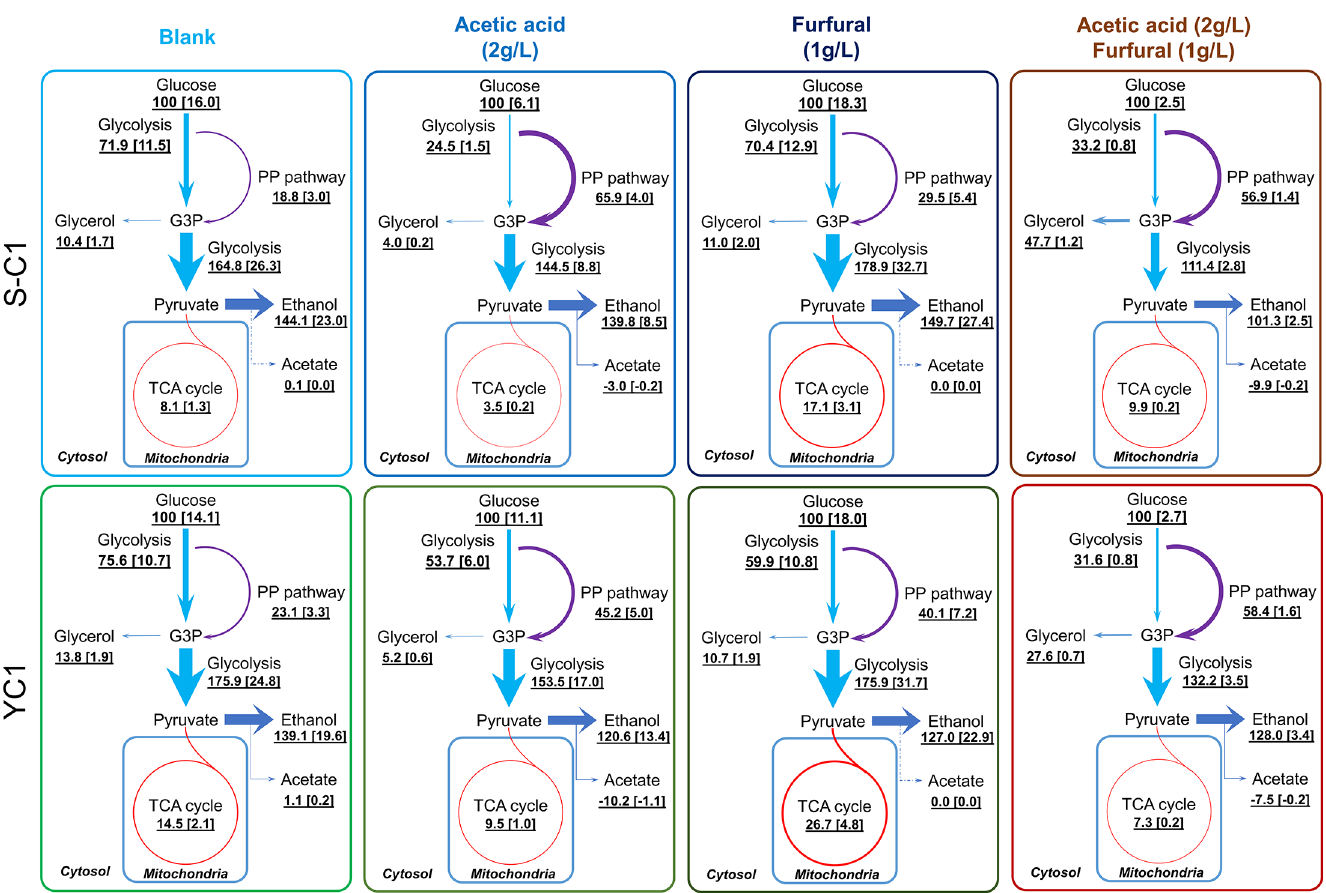
Fig 1. Metabolic flux distribution of the S-C1 strain and YC1 strain under different stress conditions. The values outside the bracket are relative flux values normalized to glucose uptake rates as 100. The values inside the bracket are real flux values in mmol/g/h. Abbreviations used are: G3P, glyceraldehyde 3-phosphate; TCA cycle, tricarboxylic acid cycle. The line widths are linearly correlated with the normalized flux values (glucose uptake rate as 100). The dashed line indicates the flux is zero.